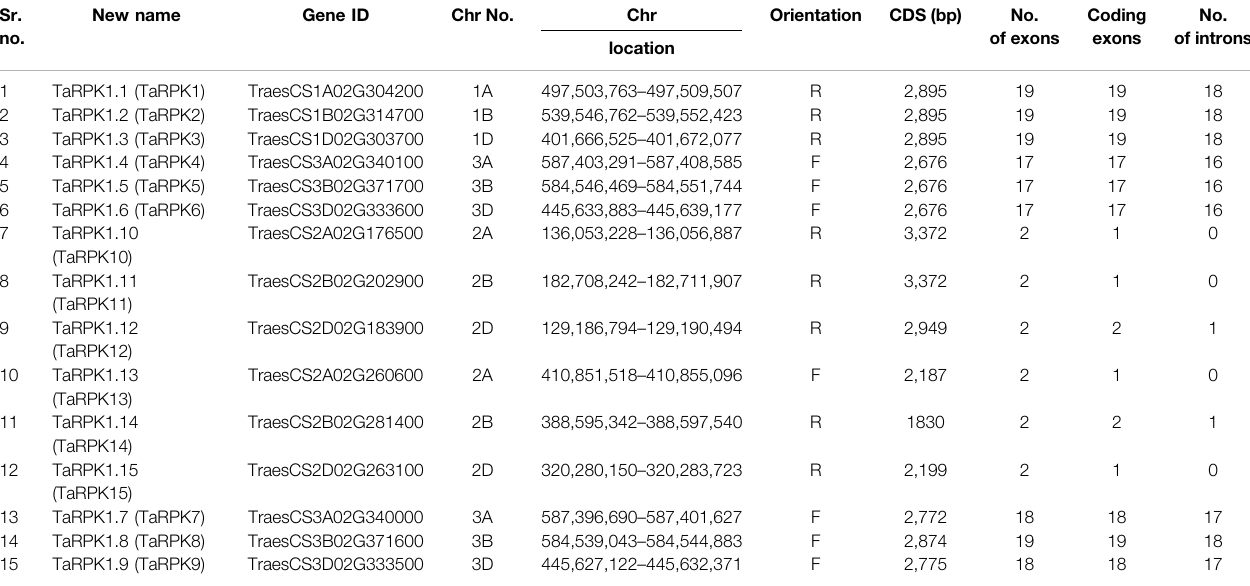
TABLE 1 | In silico prediction of identi fi ed RPK1 genes in wheat and sequence characteristics. Sr. no.